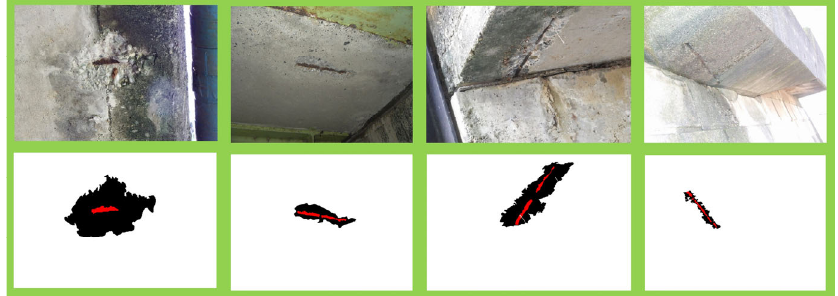
Figure 4. Example of a pair of images and label data from dataset A.